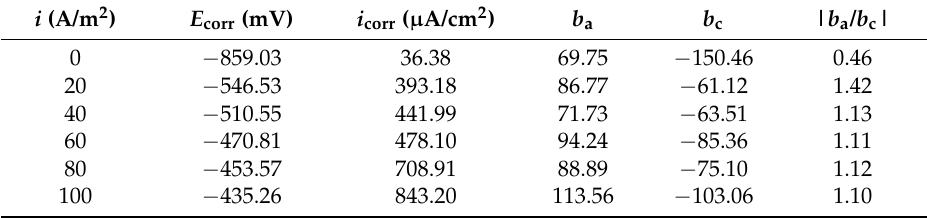
Figure 5. The polarization curves of 3PE-coated X80 steel under DC anode ( a ) and cathode ( b ) polarization.